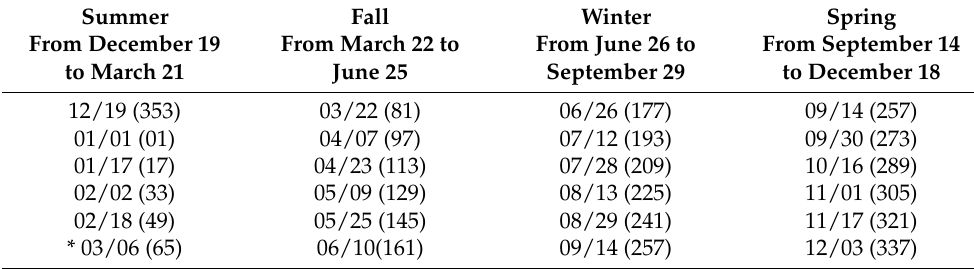
Table 3. Seasons and initial date of the composition of the EVI images (Julian day).